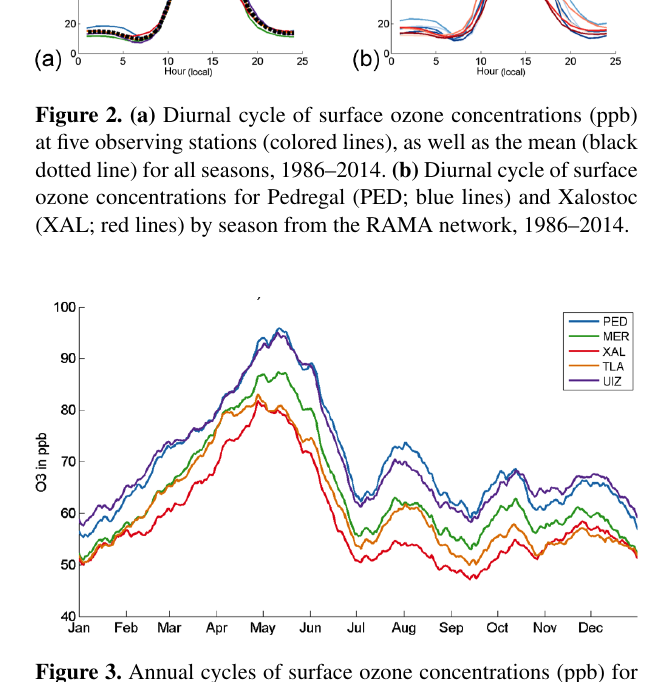
Figure 3. Annual cycles of surface ozone concentrations (ppb) for five observing stations for hours 12:00–16:00LT (local time) from the RAMA network, 1986–2014. Observations are smoothed using a 30-day running